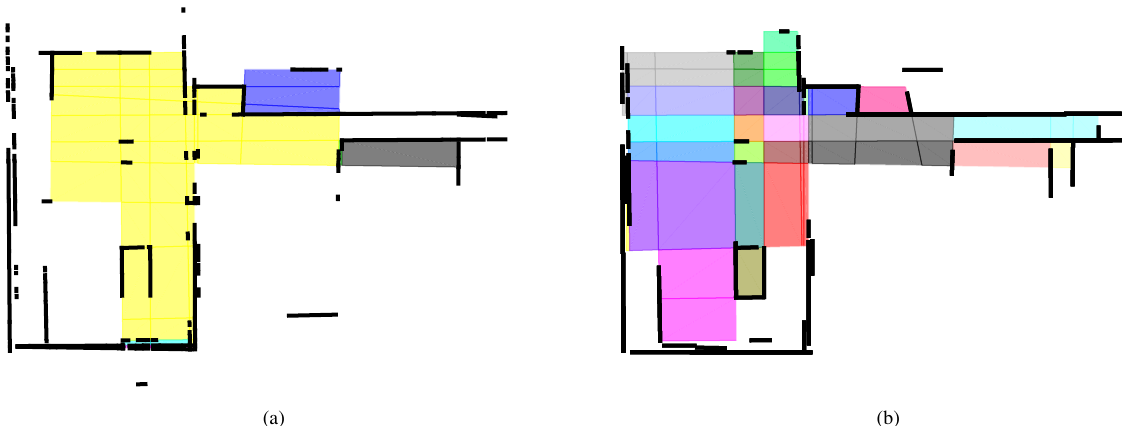
Figure 12. Dataset UVigo : floor plans obtained with (a) the proposed method and (b) the method by (Magri and Fusiello, 2018). This figure is best viewed in colours.